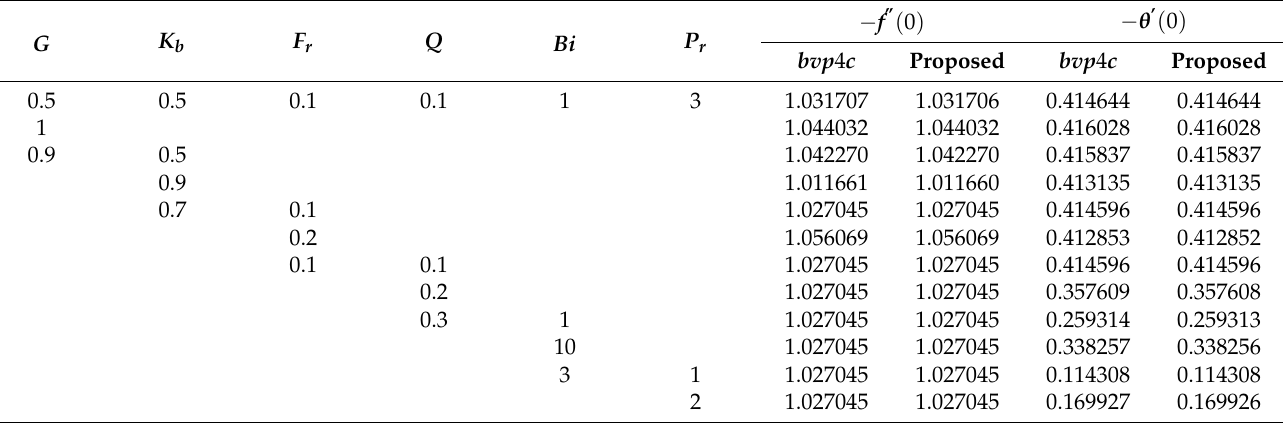
Table 1. List of numerical values for − f (cid:48)(cid:48) ( 0 ) using the proposed scheme and Matlab solver bvp 4 c when λ = 0.1 and R d = 0.5.